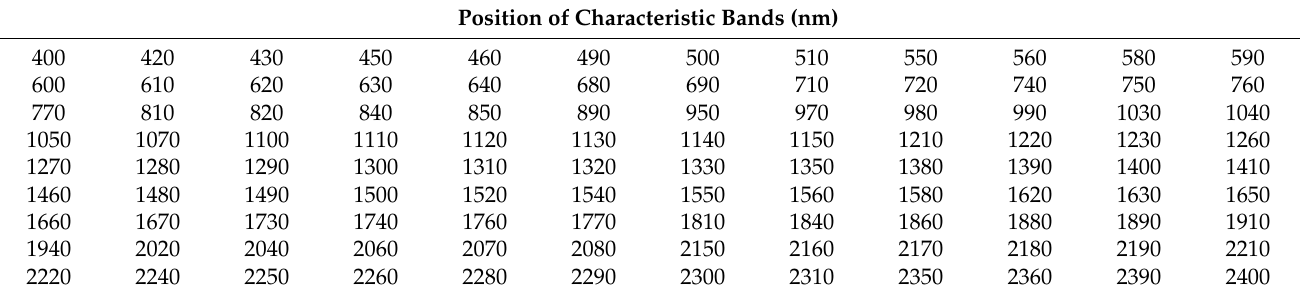
Table A1. Characteristic bands of Initial selected by